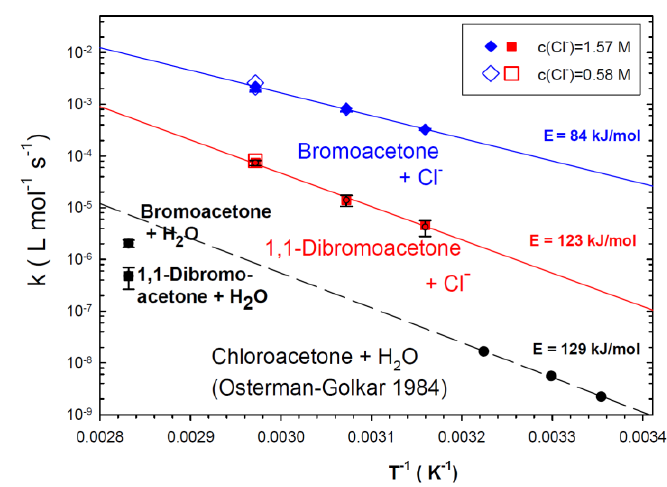
Figure 9. Temperature dependence of the rate constants for the reactions of brominated acetones with chloride and water and data on the hydrolysis of chloroacetone from Osterman-Golkar (1984) [21] in comparison with hydrolysis data at 353 K on bromoacetone (diamond) and 1,1-dibromoacetone (square). The 1 / T scale ends at T = 293 K for convenience. Table 2. Rate constants for nucleophilic exchange reactions with chloride and hydrolysis of bromoacetone and 1,1-dichloroacetone.